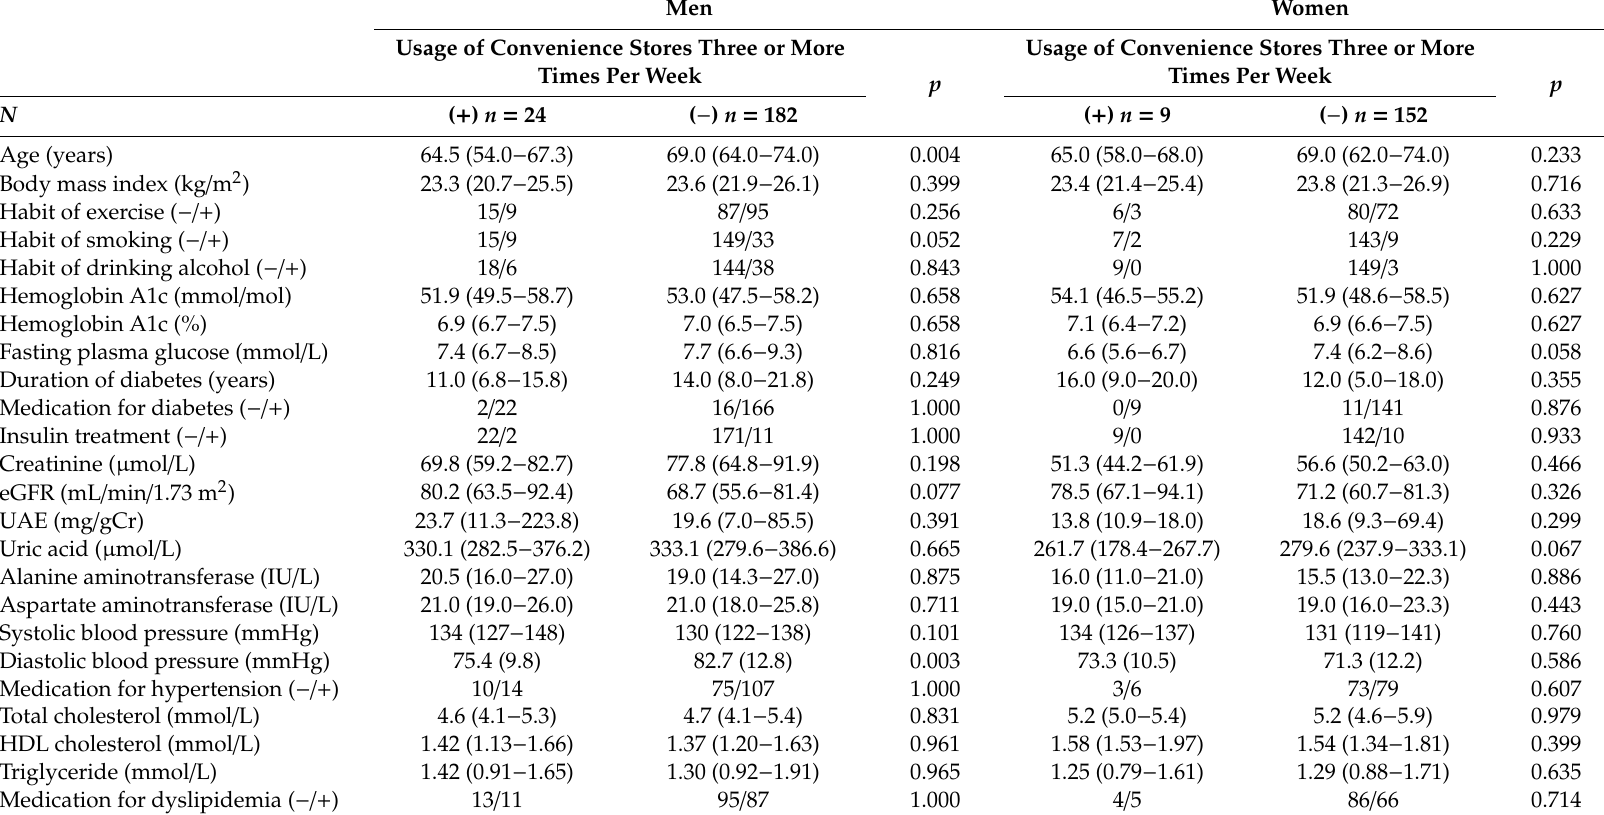
Table 1. Clinical characteristics of study